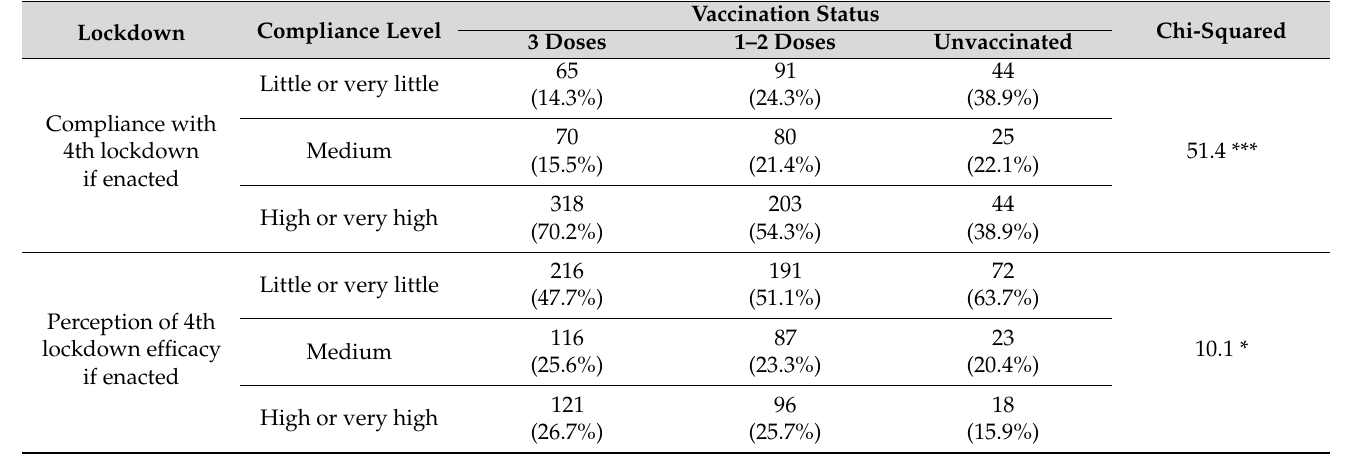
Table 3. Distribution ( N (%)) of public attitudes toward a possible fourth lockdown according to vaccination status ( N = 940).